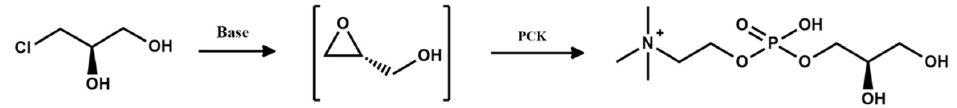
a Conversion was calculated from the ratio between the phosphorylcholine peak and the product peak in the 1 H NMR spectrum.